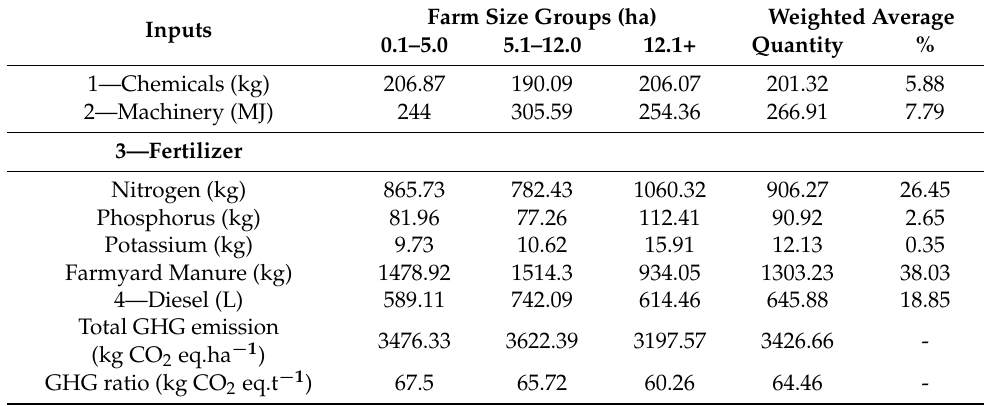
Table 6. Econometric result of GHG emission (endogenous variable: lnGHG). Cobb-Douglas Model Exogenous Variables Coefficient t-Value